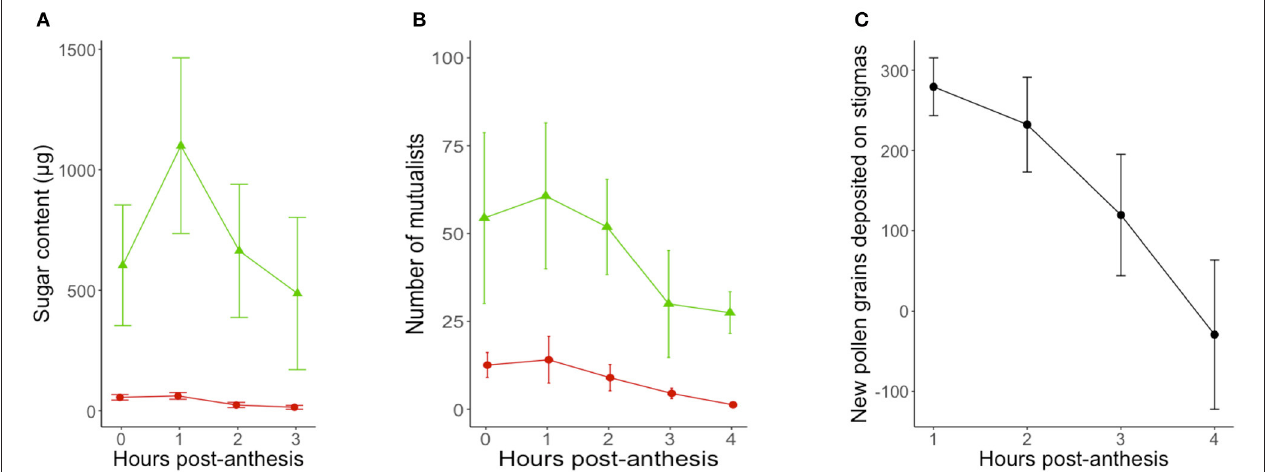
FIGURE 2 | Timing of (A) reward secretion ( n = 20 flowers-leaves), (B) mutualist activity (n = 1,604 flowers; n = 10 sites/day) and (C) pollen deposition ( n = 20 flowers) in Turnera velutina during the anthesis period (08:30–12:30), showing raw data from field observations (mean ± se). Red circles show floral nectar and the activity of pollinators in flowers, whilst green triangles show extrafloral nectar and the activity of ants at extrafloral nectaries.